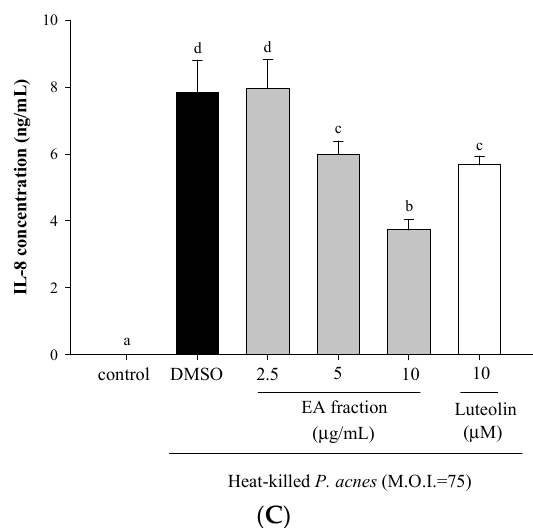
Figure 1. Effect of ethyl acetate (EA) fraction of ethanolic extract from Scutellariae radix on viability of monocytic THP-1 cells, and pro-inflammatory cytokine productions by P. acnes -stimulated THP-1 cells. Cell viability ( A ) was determined by MTT assay in cells incubated with vehicle control alone, or the indicated concentrations of EA fraction for 24 h. IL-1 β ( B ) and IL-8 ( C ) were determined in cells co-incubated with P. acnes (M.O.I. = 75) and the indicated concentrations of samples for 24 h. DMSO (0.1%) was a vehicle control, luteolin was a reference control. A control experiment without P. acnes treatment was conducted in parallel. Each column shows the mean ± SD. Values with the same letter are not significantly different as determined by Duncan’s multiple range tests.